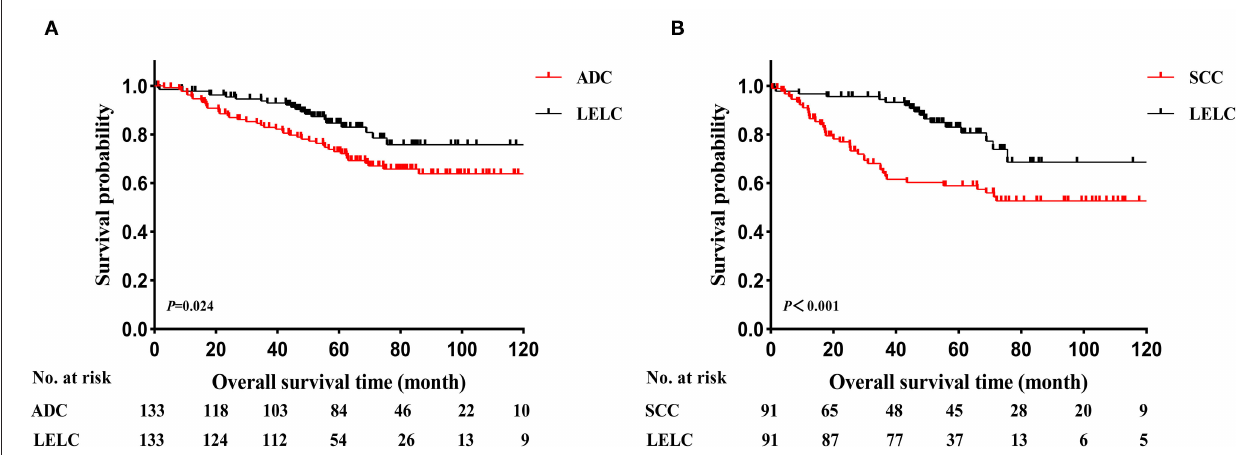
FIGURE 3 | Kaplan-Meier estimates of OS in LELC vs. other NSCLCs after PSM. (A) LELC vs. ADC and (B) LELC vs. SCC. LELC, lymphoepithelioma-like carcinoma; ADC, adenocarcinoma; SCC, squamous cell carcinoma; NSCLC, non-small cell lung cancer; PSM, propensity score matching; OS, overall survival.